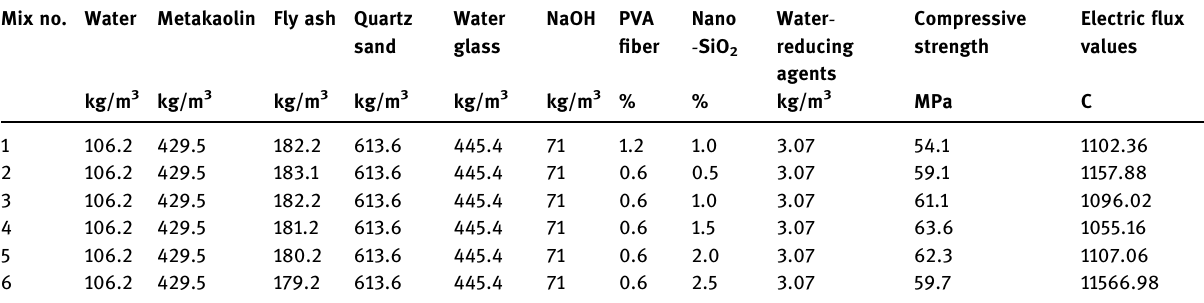
Table 5: Mix proportions of geopolymer mortar for test set Mix no. Water Metakaolin Fly ash Quartz